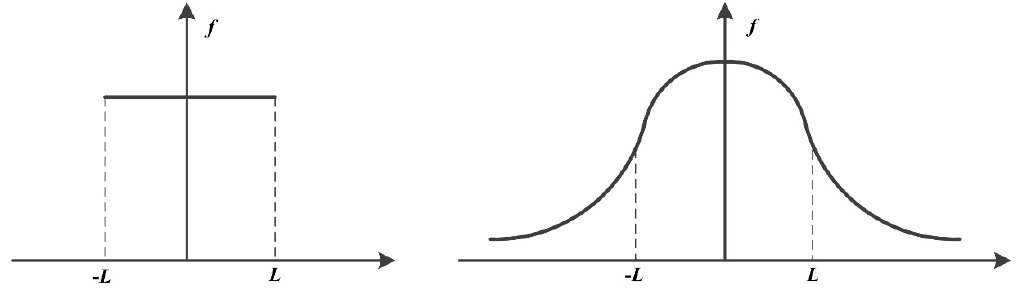
Figure 2. Probability density functions of basic fly distance range and the improved.